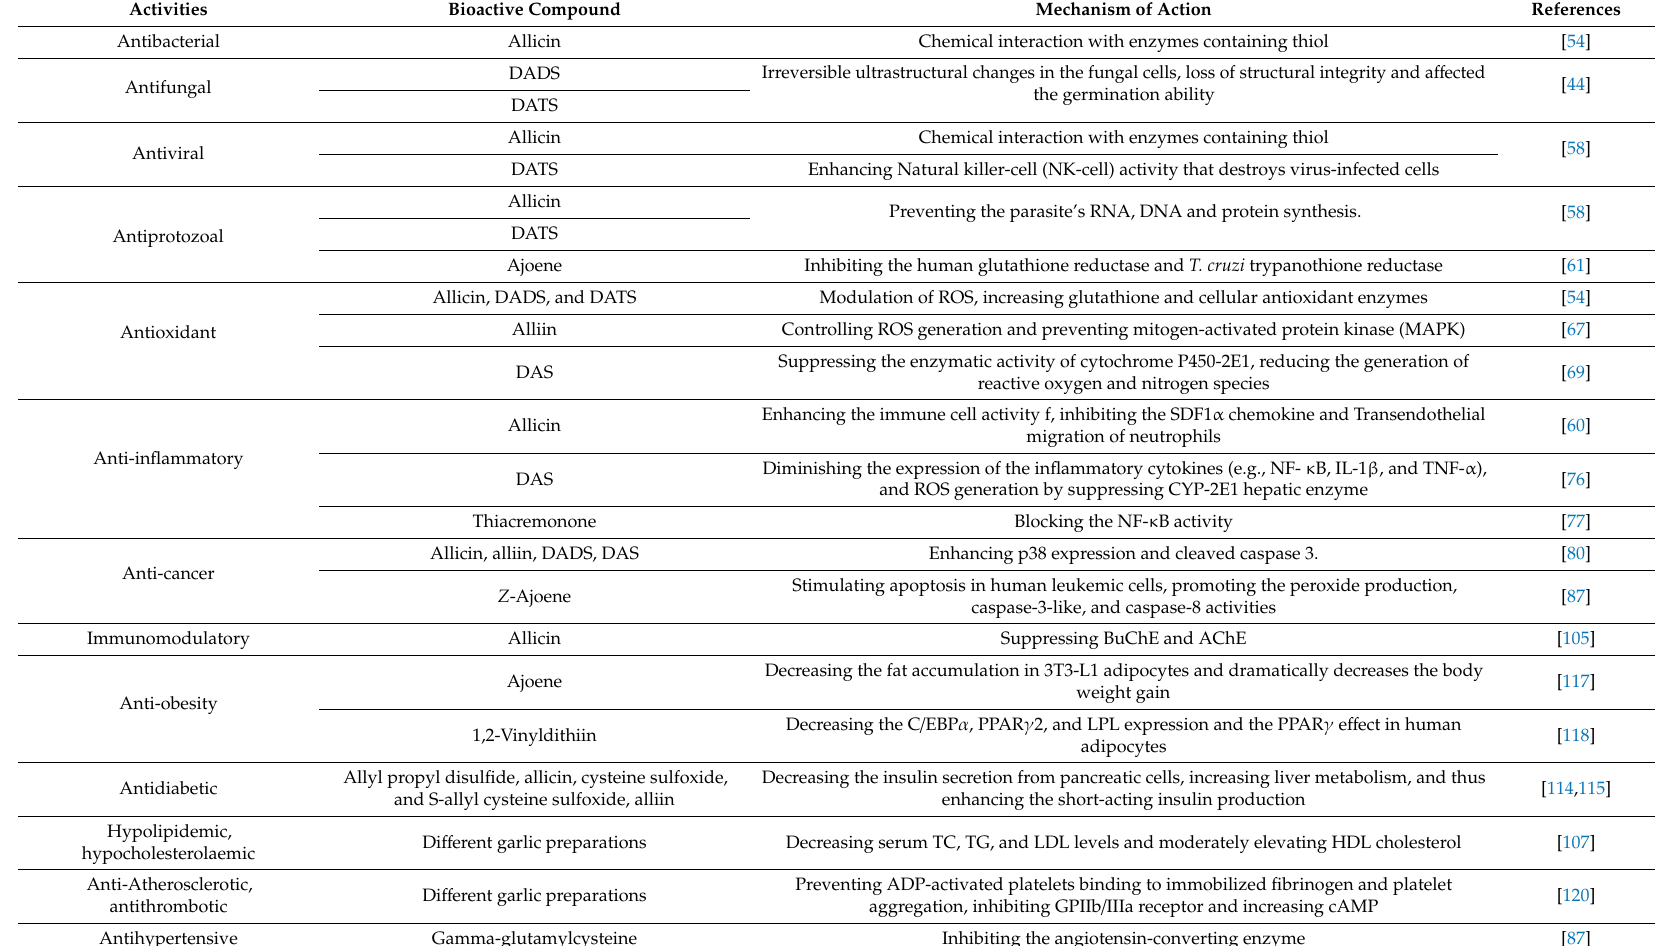
Table 2. The pharmacological activity of garlic ( Allium sativum ) and its related